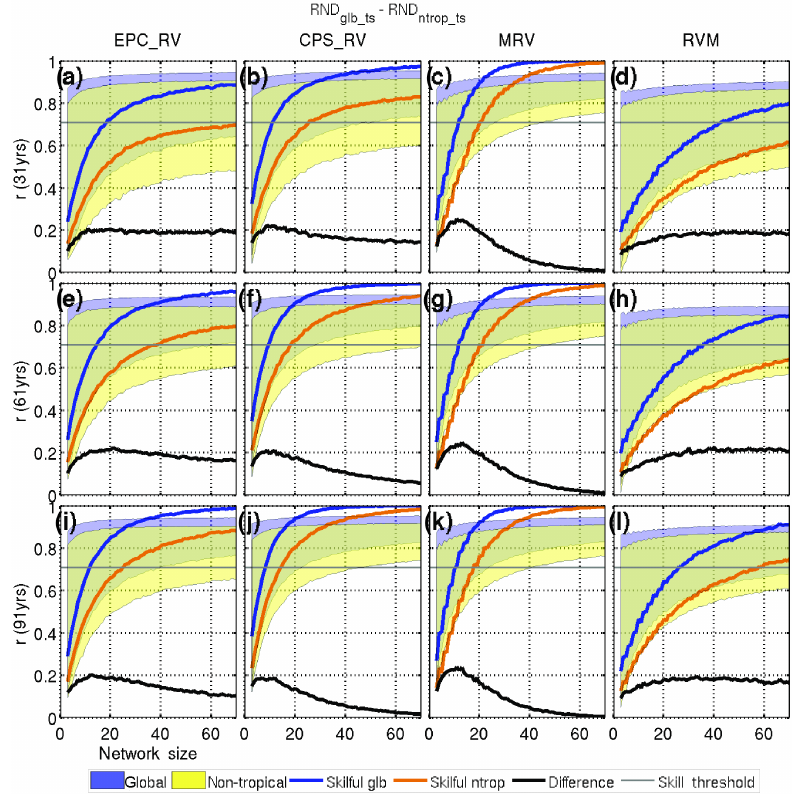
Figure 4. A comparison of reconstruction skill of the global RND glb_ts (blue) and the non-tropical RND ntrop_ts (yellow) experiments. Correlation coefficients are calculated between the reconstructed running variance and ENSO running variance ( y axis), plotted against the proxy network size ( x axis). The coloured regions show the range of these coefficients, from the 5th to the 95th percentile, with overlapping regions shown by the yellow-green colouring. The thick blue and orange lines show the proportion of skilful reconstructions for the RND glb_ts and RND ntrop_ts experiments respectively. Skilful reconstructions are defined as explaining greater than 50% of variance (grey line). The black line is the difference in skill between the RND glb_ts (blue line) and RND ntrop_ts (orange line) experiments. Each row corresponds to different calibration window lengths, titled on the y axis. Each column represents different reconstruction methods, titled at the top of the